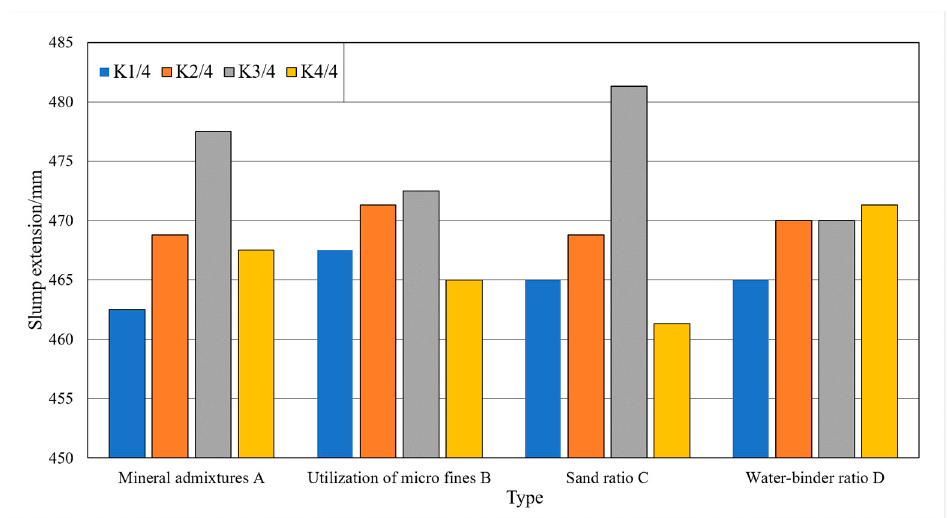
Figure 5. Trend of the influence of factors on the results of slump expansion test.